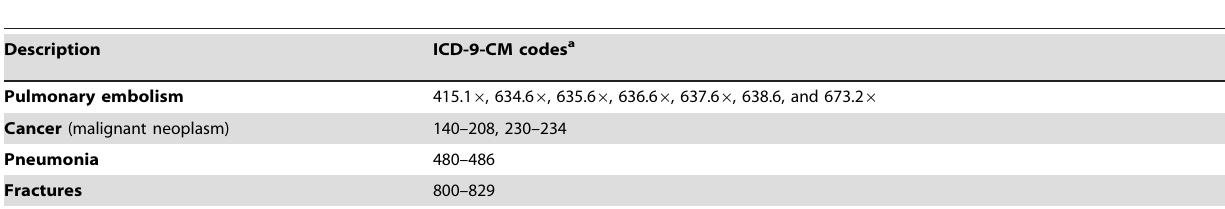
Table 1. The International Classification of Diseases, Ninth Revision, Clinical Modification (ICD-9-CM) codes for identification of selected medical diagnoses, 2001 2